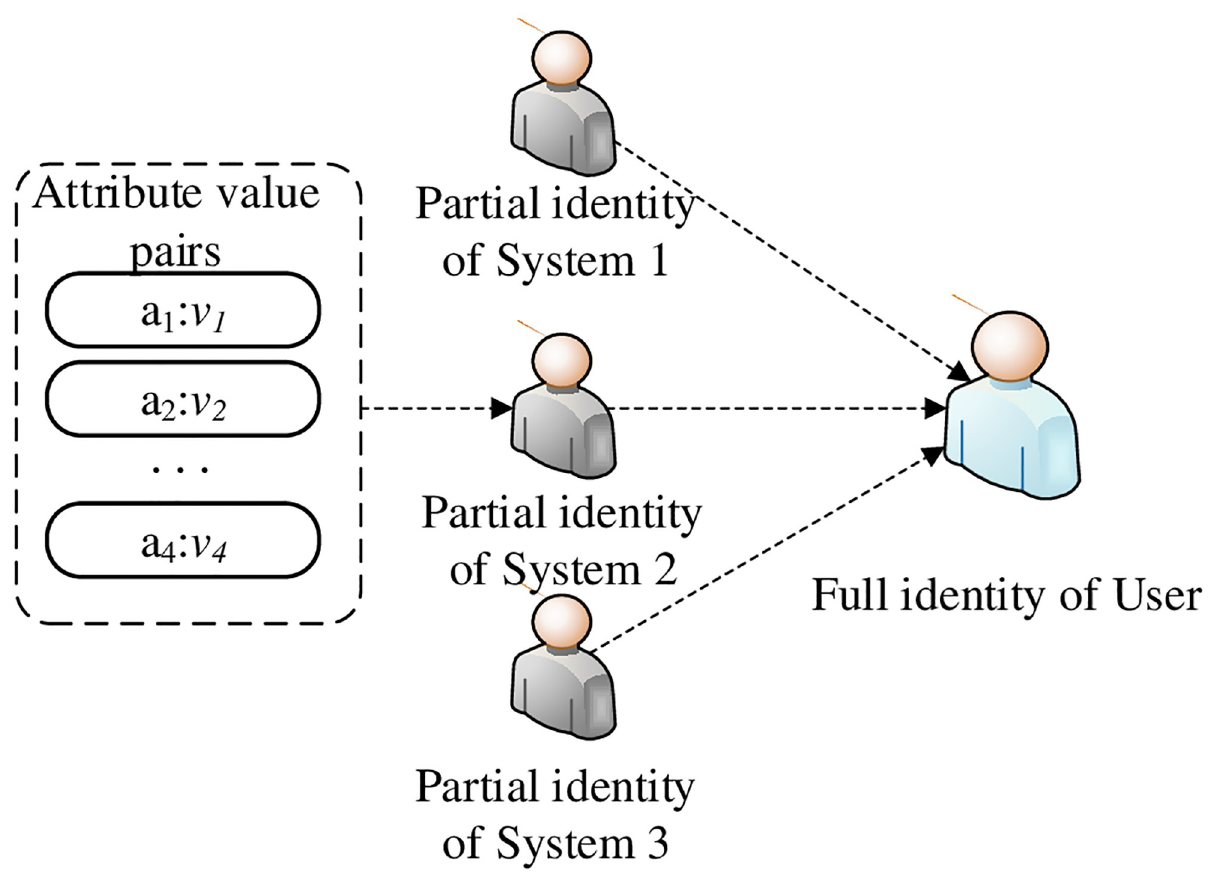
Fig 1. Full identity of